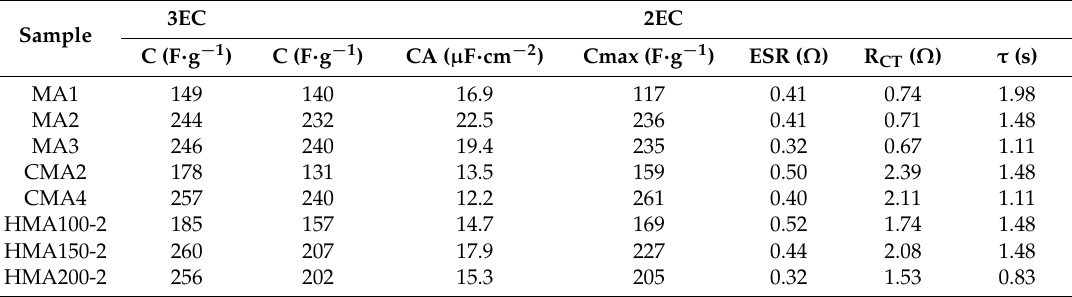
Table 4. Capacitances from GCDs in 2 and 3EC at 1 A · g − 1 . C max at 1 mHz, equivalent series